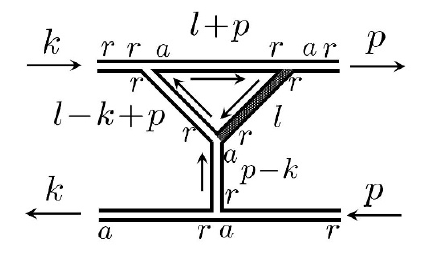
Figure 12 . A typical interference rung containing nearly collinear